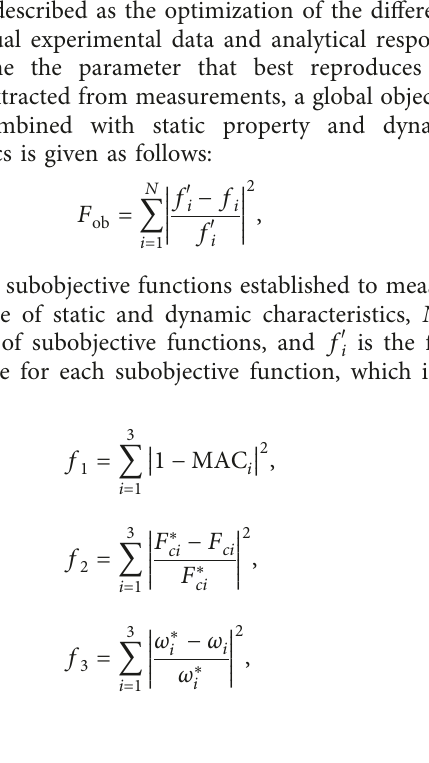
Figure 7: Main tower modeling. (a) Detailed model. (b) Simplified model. (c) Pushover